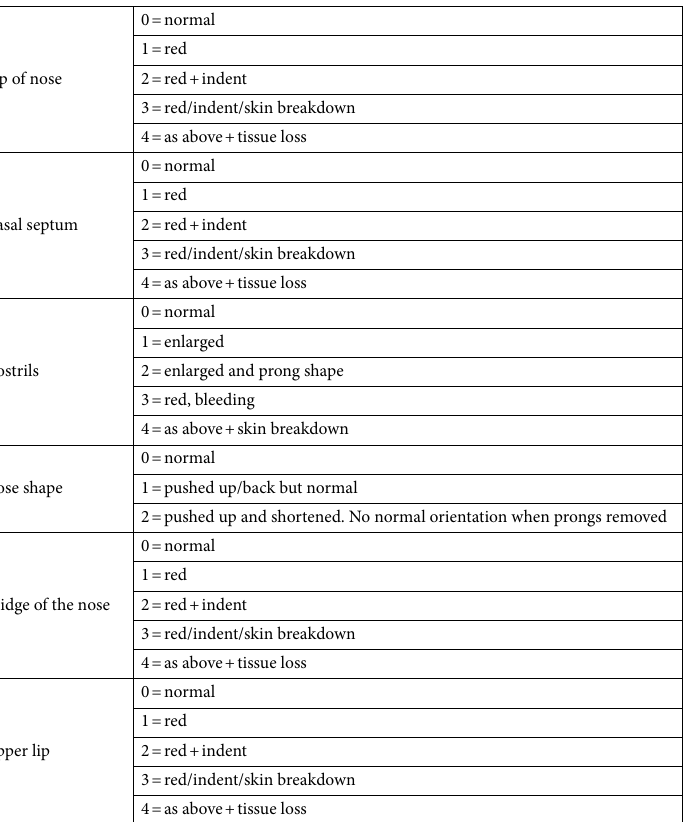
Table 1. Nasal injury assessment score chart. Scoring : 0 = no injury, 1–4 = mild injury, 5–6 = moderate injury, > 7 = severe